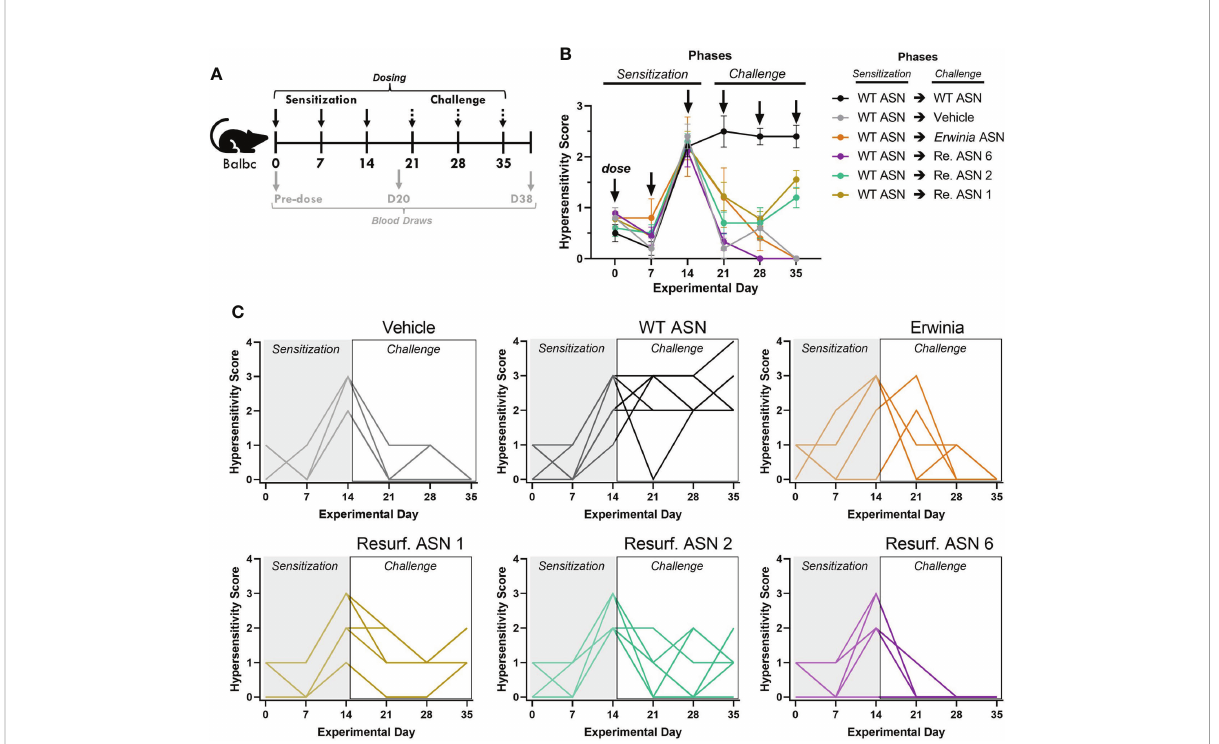
FIGURE 5 Resurf. ASNs alleviate treatment related hypersensitivity in mice. (A) Schematic of sensitization and hypersensitivity challenge model. Wildtype Balbc mice were given three intravenous (IV) sensitization doses of WT ASN (50µg per dose) after which mice were randomized across experimental groups to normalize hypersensitivity scores. Mice were then given three IV challenge doses of Vehicle control, WT ASN as a positive control, Erwinia ASN as a negative benchmark control, or one of three selected Resurf. ASN variants. Hypersensitivity reactions were monitored for the fi rst 30 minutes post-dose and quanti fi ed on a four-point scale based on severity (see Materials and Methods for further details). Blood was drawn and serum harvested on Days 0 (pre-dose), 20 (prior to initiation of challenge phase) and 38 (at the completion of the study) to quantify emergence and titer of ADAs (see Supplementary Figure 3). (B) The mean and standard error mean for hypersensitivity scores following each dose for each experimental group are shown. See Table 3 for statistical comparison of each experimental group compared to WT ASN for each dose of the challenge phase. (C) The hypersensitivity scores recorded for each individual mouse is shown for each respective experimental group. Data are shown for an N = 1